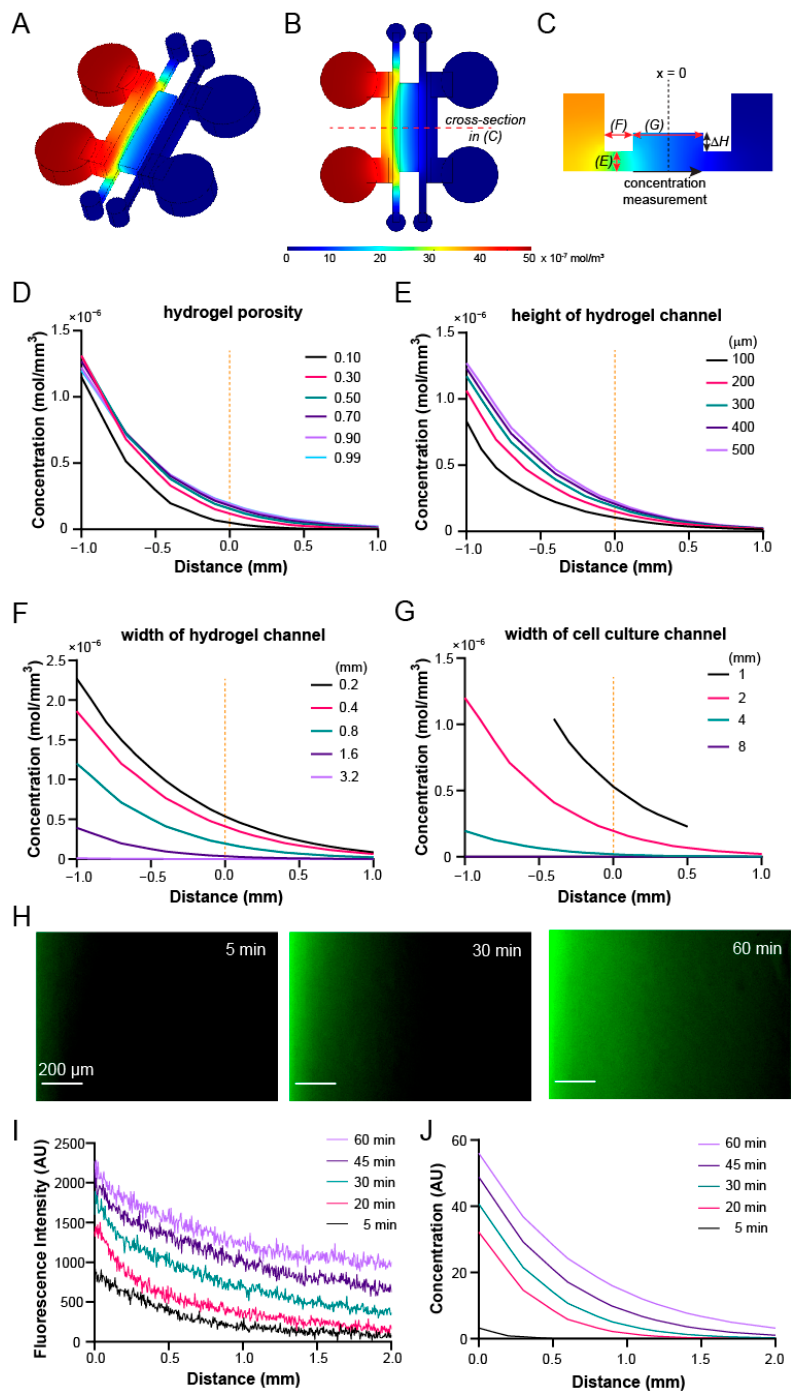
Figure 4. Characterization of diffusion with COMSOL Multiphysics ® and FITC-Dextran diffusion. ( A ) Isometric, ( B ) top, and ( C ) cross-sectional views of concentration distribution throughout the diffusion microdevice in COMSOL simulation. ( D – G ) COMSOL parameter sweep results of the effects of key geometries on the concentration profiles across the center channel. Default parameters during sweep include width of the cell chamber (2 mm), width of the hydrogel chamber (0.8 mm) and height of the hydrogel chamber (0.35 mm). Simulated effect of ( D ) hydrogel porosity, ( E ) height of hydrogel barrier, ( F ) width of hydrogel channel, and ( G ) width of the center SLB/cell loading channel. ( H ) Diffusion of 10 kDa FITC-Dextran in center chamber over time. ( I ) Quantification of fluorescence intensity of 10 kDa FITC-Dextran across the width of the center channel over time. ( J ) Simulated concentration profiles of 10 kDa molecule across the center channel over time.